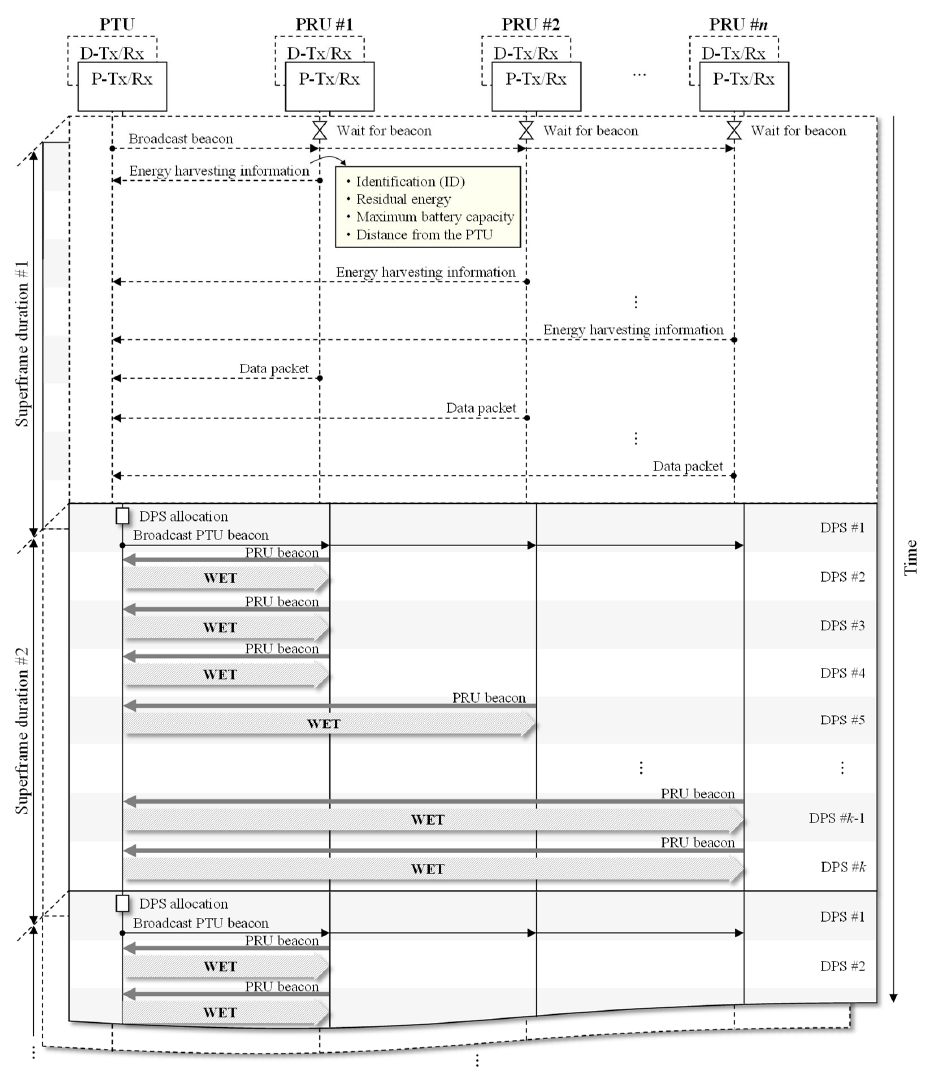
Figure 3. Overall operation of REE ‐